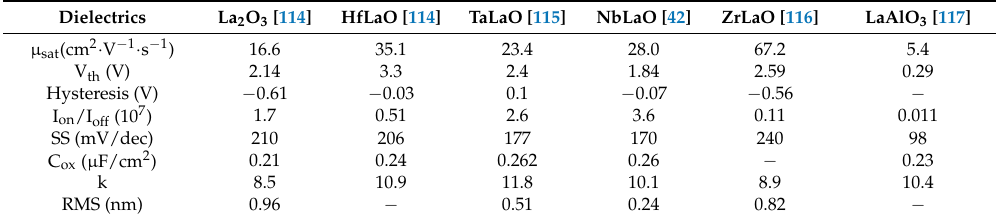
Table 3. Characteristics of IGZO TFTs with La-based high-k gate dielectrics.